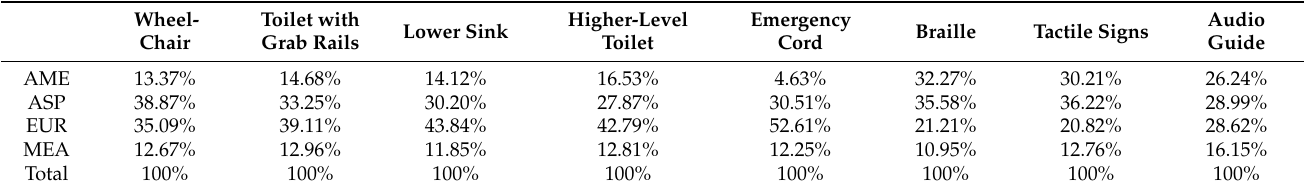
Table 2. Percentage of accessible facilities in hotels by region over the total adapted hotels.